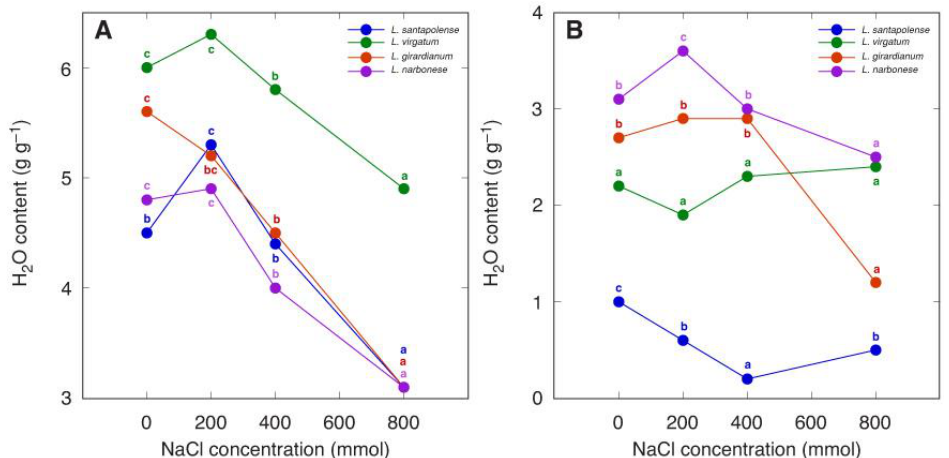
Figure 9. Effect of increasing salinity on water content of leaves ( A ) and roots ( B ) of four Limonium species with different geographic distribution patterns. Different letters of respective color indicate statistically significant differences ( p < 0.05) for the same species. Data were taken from Al Hassan et al., 2017 and recalculated